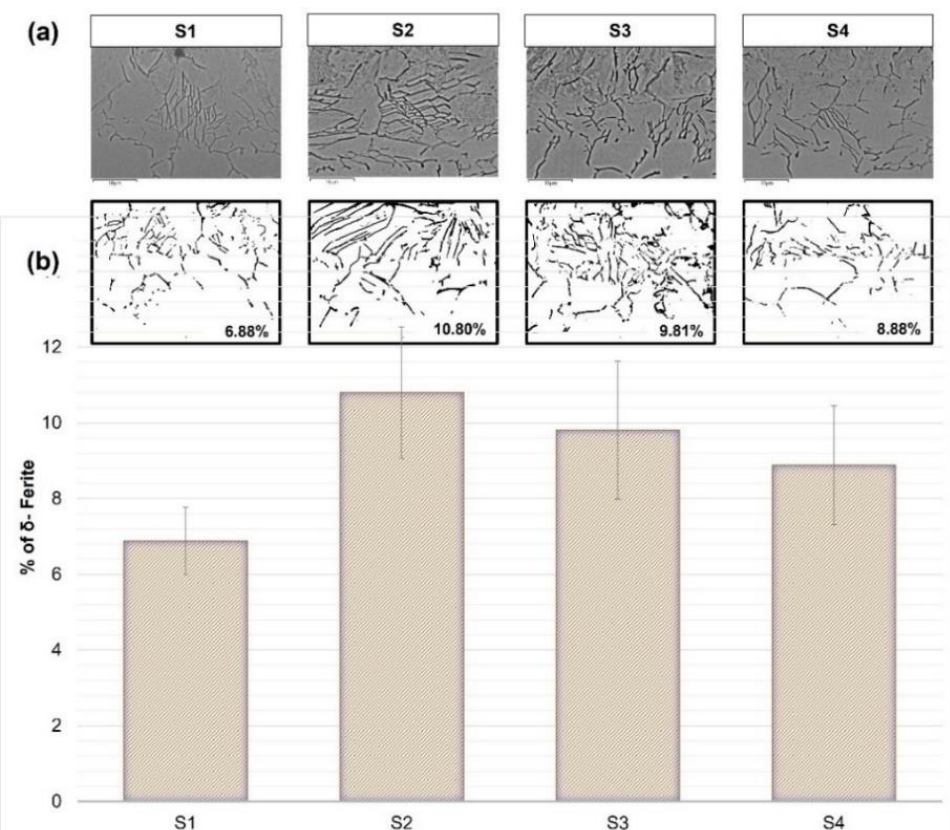
Figure 10. ( a ) SEM micrographs revealing the presence of δ -ferrite near the interface zone across track A, zone 2, for each set of process parameters (S1 – S4); ( b ) % of δ -ferrite measured across the interface by image analysis.